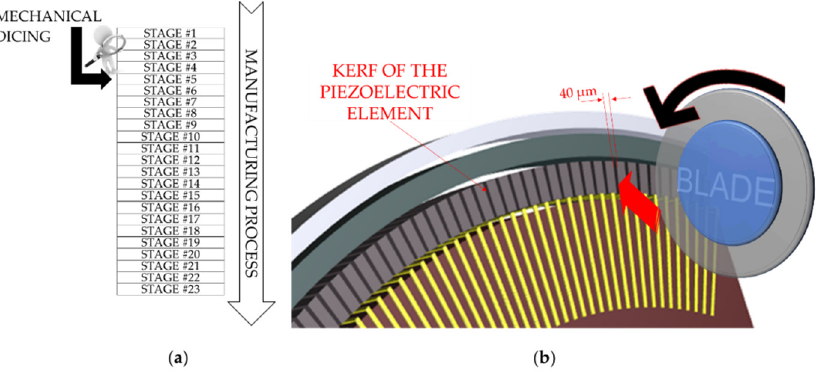
Figure 2. The manufacturing of an US probe: ( a ) the stages of the process; ( b ) the mechanical dicing of the US array.